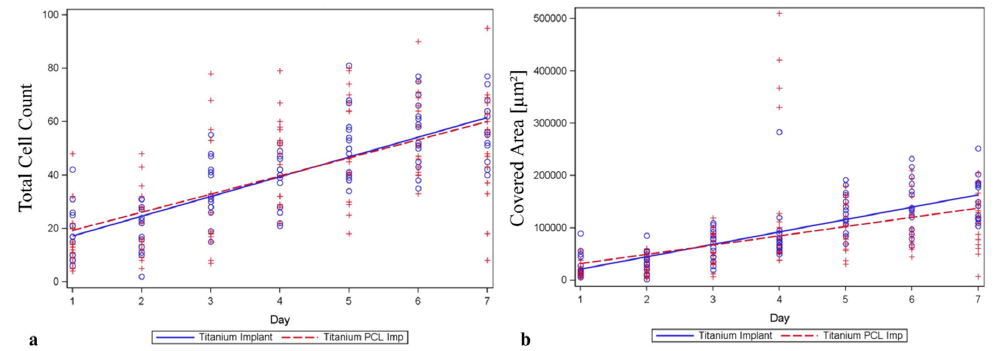
Figure 8. LCI of murine osteoblasts seeded on titanium implants and titanium implants covered with PCL (poly- ε -caprolactone). ( a ) Cell count meaning cells counted on the implant and ( b ) cell spreading area development (Covered Area) over the implant surface over seven days were examined. Neither for cell count nor for cell spreading areas could significant difference between the two materials be observed. The homogeneity of the regression coefficients was tested using the F -test for interaction between time and implant materials (circle = single data for titanium implant; plus sign = single data for titanium PCL implant).